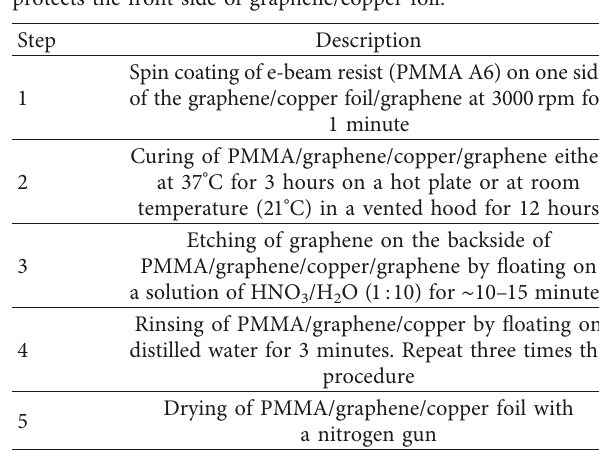
Table 1: Process to remove chemical vapor deposited (CVD) graphene from the backside of copper foil by floating on a dilute nitric acid solution. A polymethyl-methacrylate (PMMA) thin film protects the front side of graphene/copper foil.